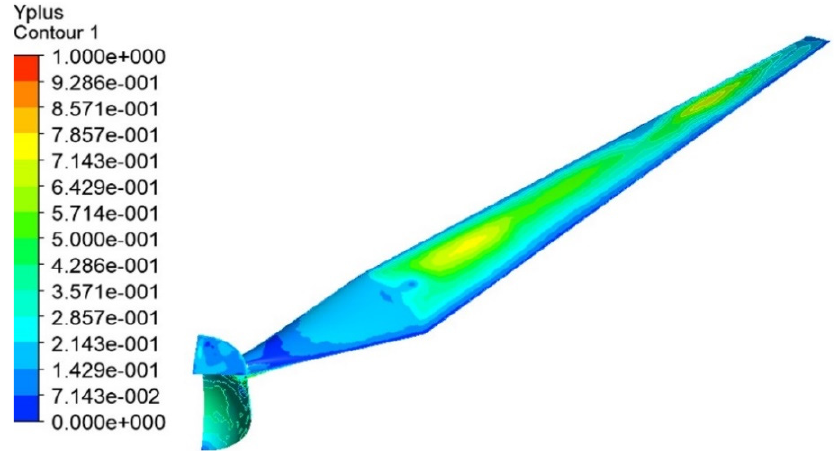
Figure 6. y+ distribution over the blade.